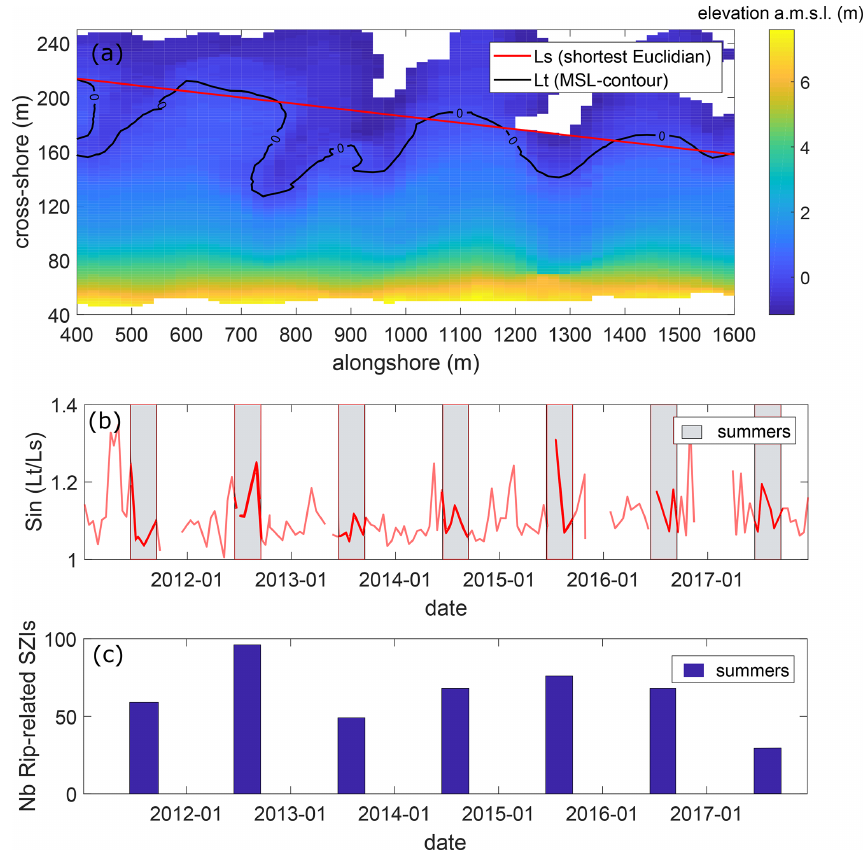
Figure 4. (a) Example of a digital elevation model of Truc Vert beach on 29 April 2013, with the colour bar showing elevation above mean sea level. The red line indicates the shortest Euclidean distance. Time series of (b) sinuosity S and (c) number of summer rip-current-related